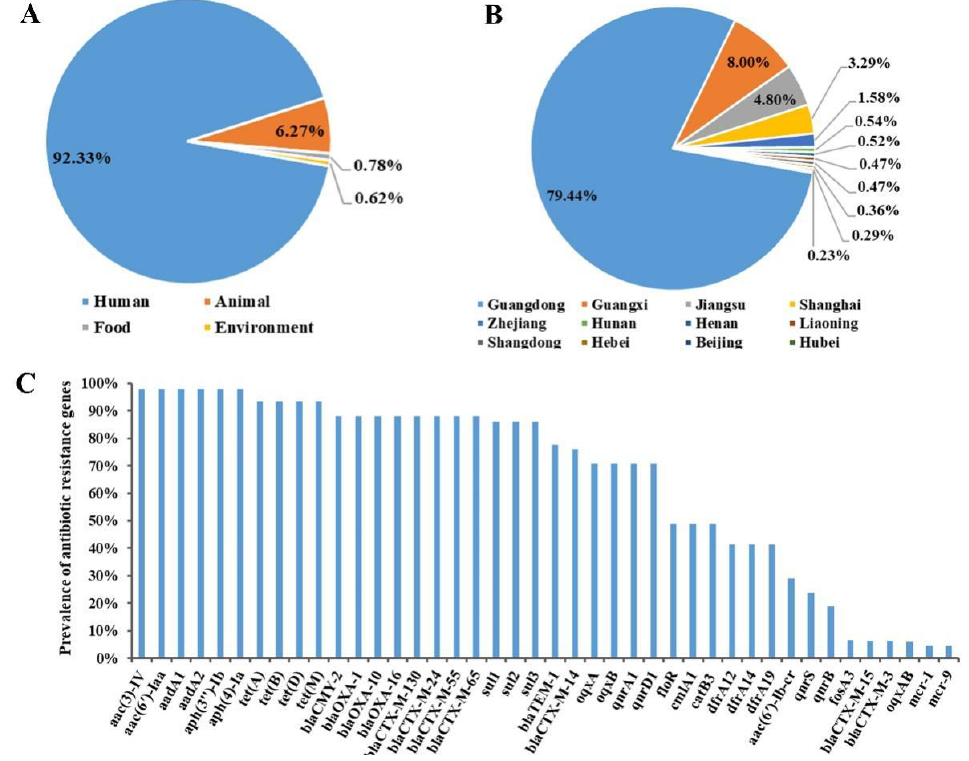
Figure 2. Data on isolates of S. 1,4,[5],12:i:- extracted from eligible studies concerning ( A ) sources, ( B ) geographical locations in China, and ( C ) detection rates of antibiotic resistance genes.